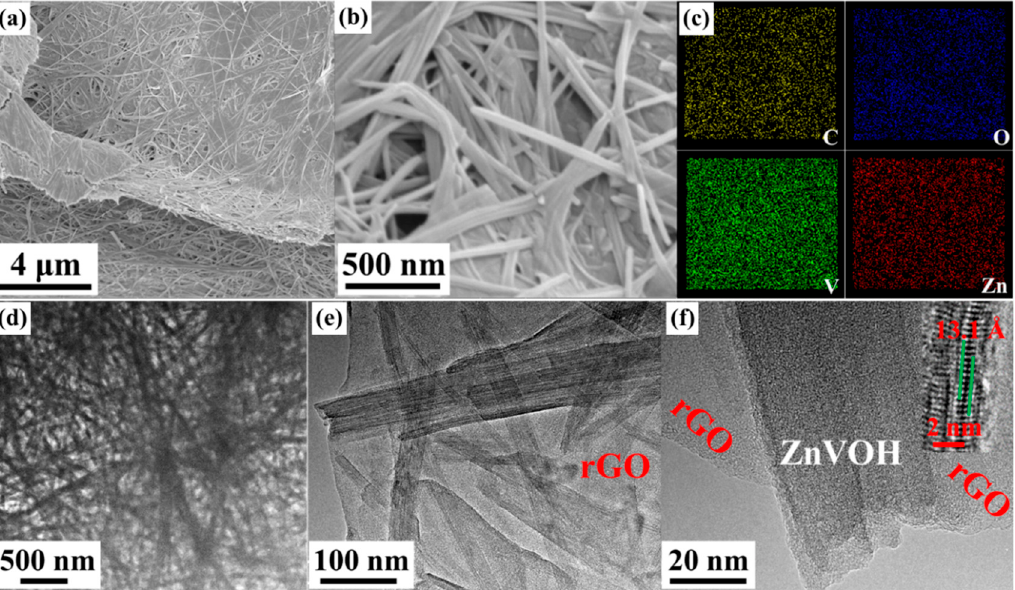
Figure 3. Morphologies of ZnVOH/rGO: ( a , b ) SEM images; ( c ) elemental mapping images collected form Figure S2; ( d – f ) TEM images and a HRTEM image is inserted.